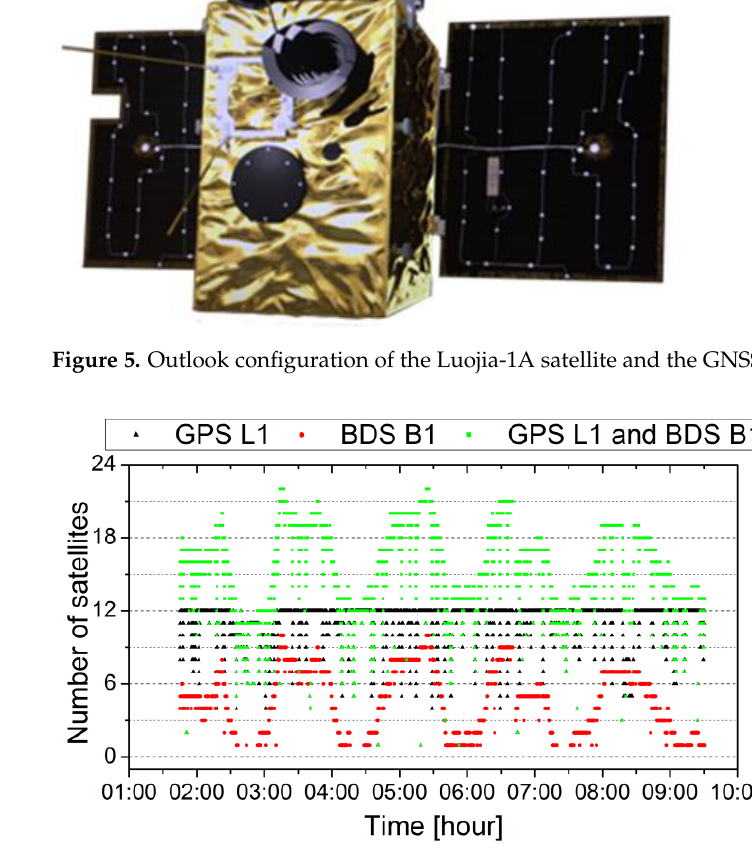
Figure 5. Outlook configuration of the Luojia-1A satellite and the GNSS antenna.